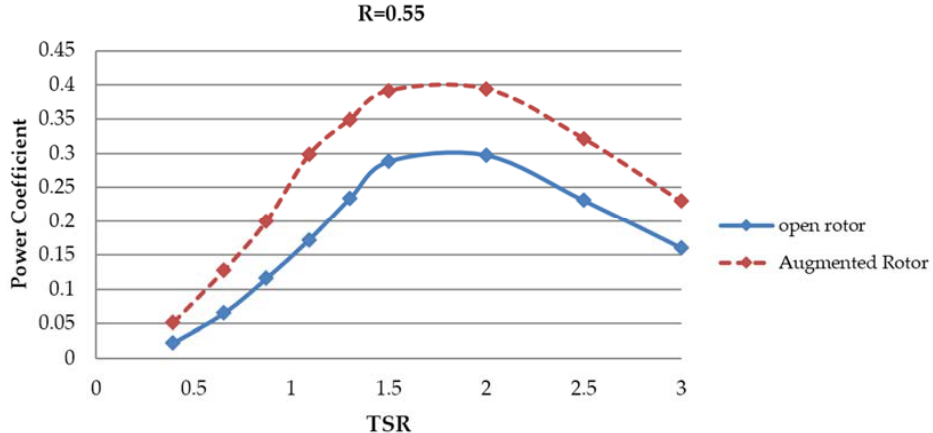
Figure 26. Power coefficient C p versus different TSR for open rotor and augmented rotor with shape ratio of the 0.55.